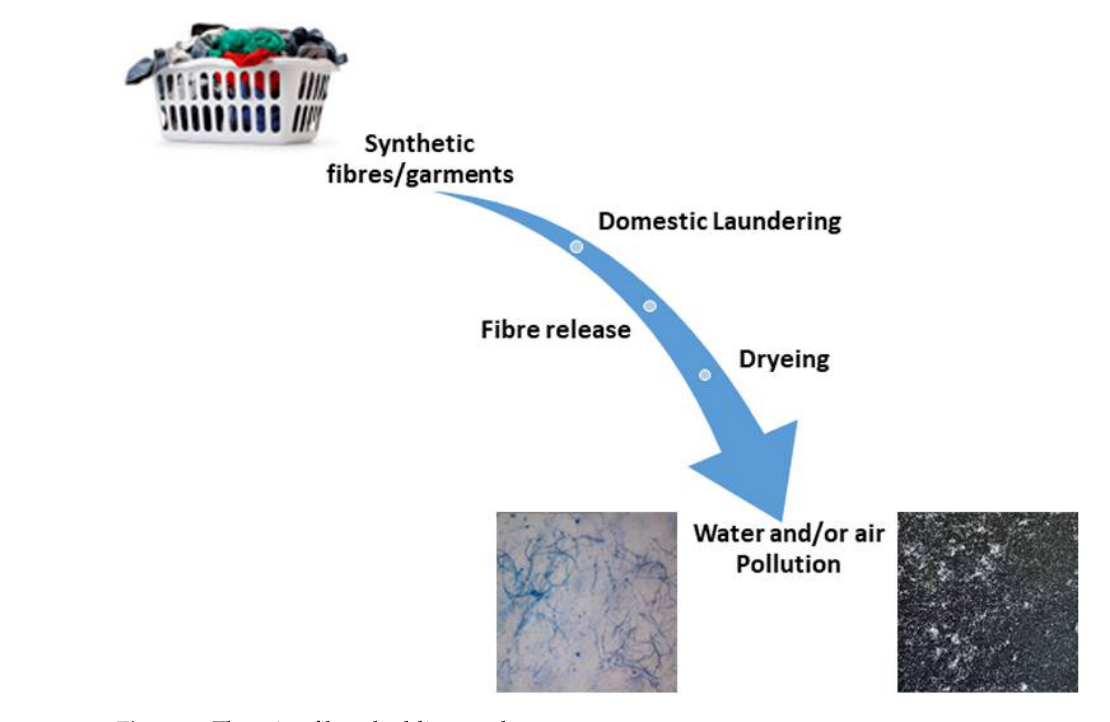
Figure 4. The microfiber shedding mode.